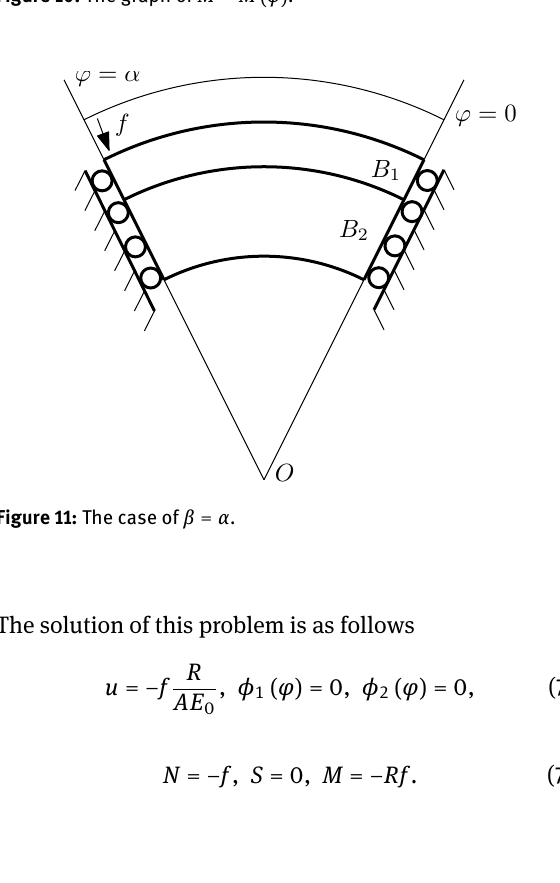
Figure 10: The graph of M = M ( φ ) .